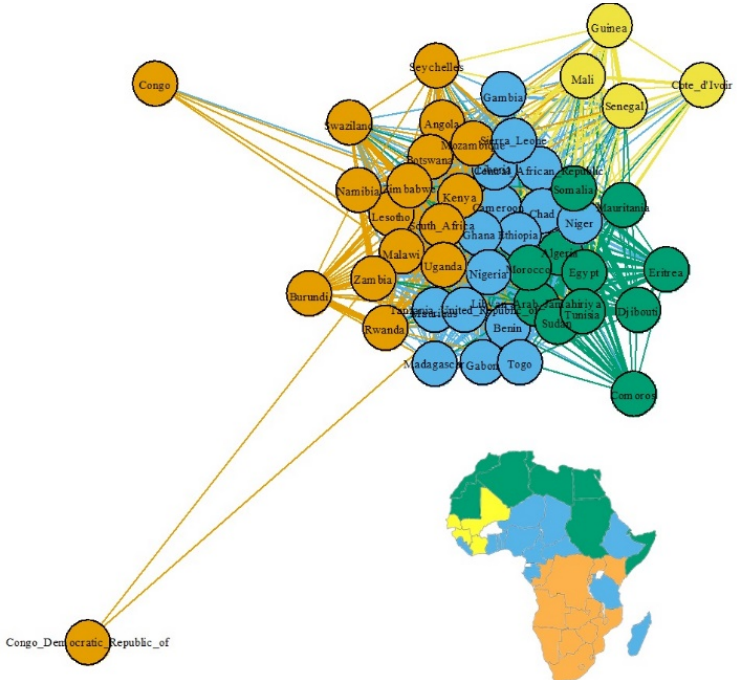
Figure 7. Network clustered by similarity of ethnic composition. Figure 8. Network clustered by similarity of ethnic